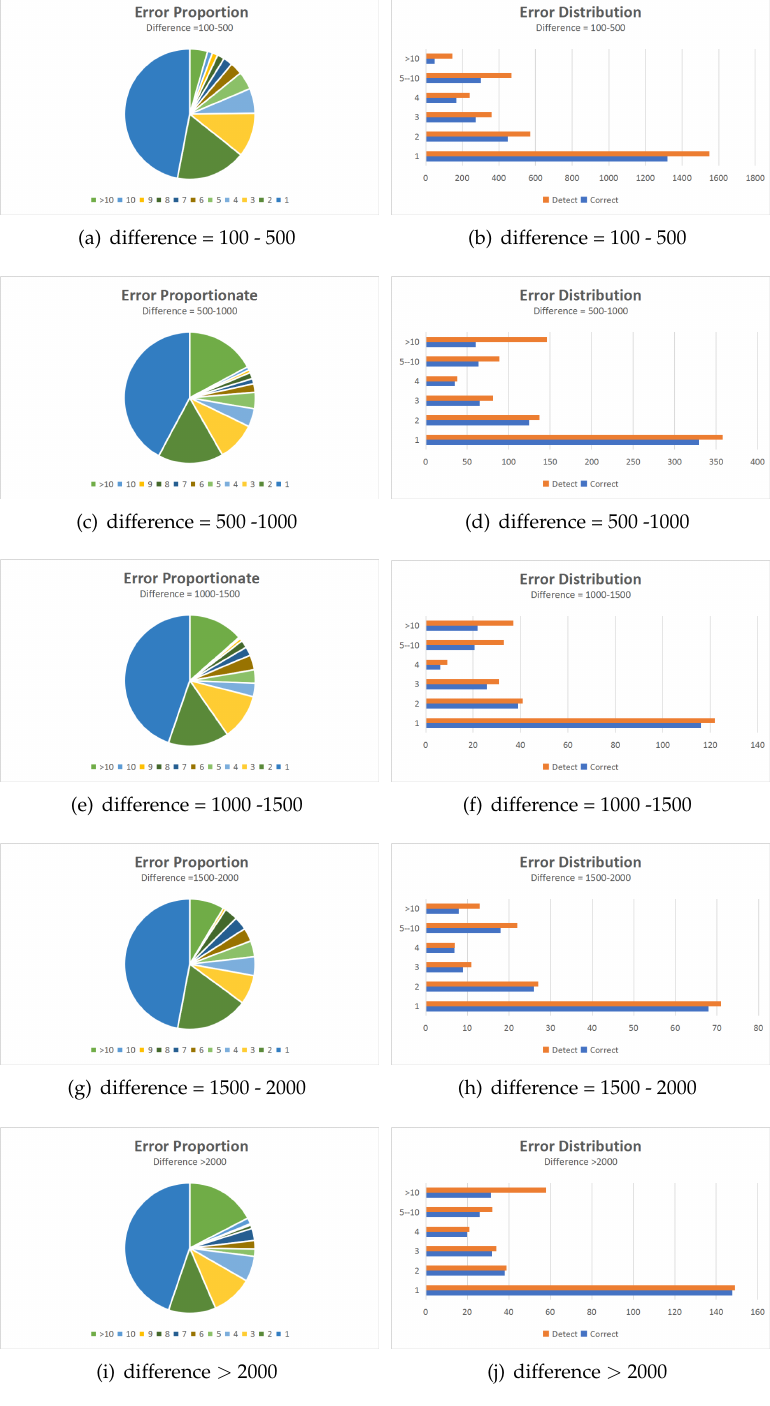
Figure 6. Weights